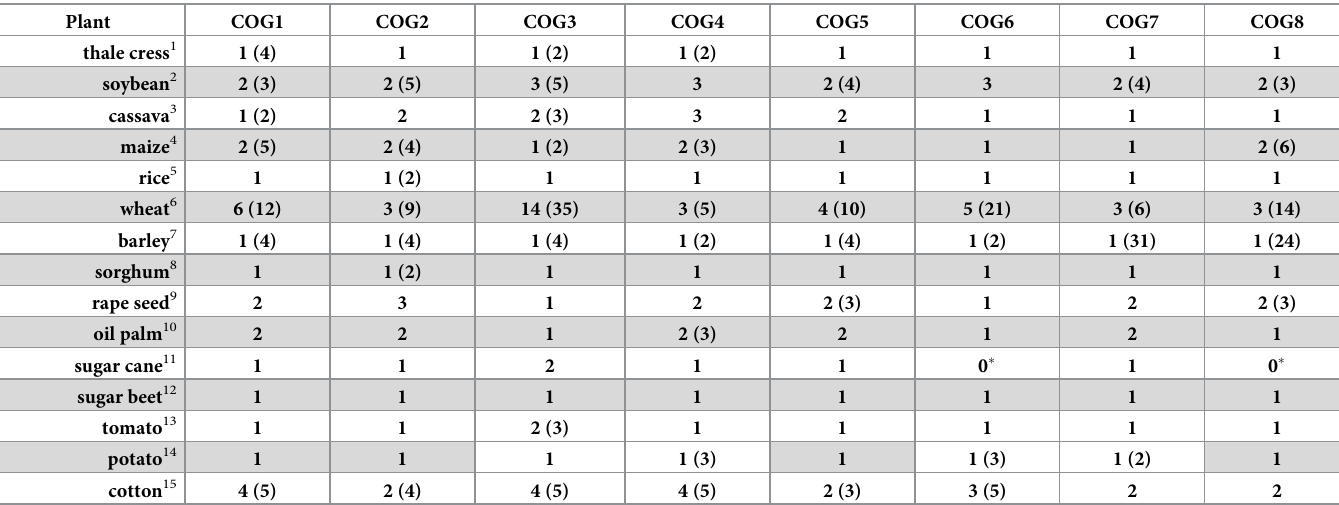
Table 2. COG paralogs in select plant